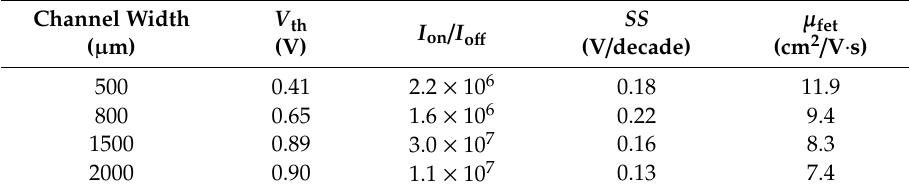
Table 2. The electrical performance parameters of a -IGZO TFT with di ff erent sizes of channel width at an oxygen flow rate of 0 sccm.